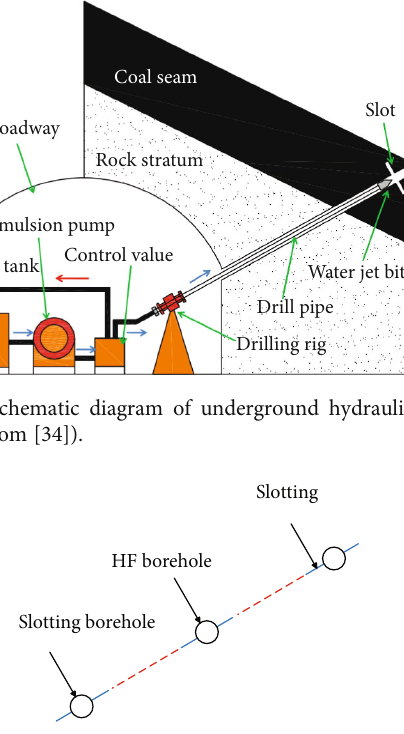
Figure 7: Combination stimulation technology of hydraulic fracturing and hydraulic